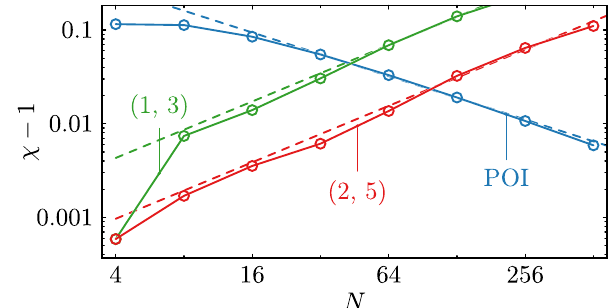
FIG. 5. Relative performance of the covariant, phase operator based interferometer (POI) (blue) and the variational (1,3) and (2,5) interferometers (green and red points, respectively) with respect to the OQI for a given system size N . The χ ratio is defined in Eq. (12), OQI corresponds to χ ¼ 1 . The dashed lines represent empirical scalings, green and red one scale as ∼ N , and blue is ∼ N − 0 . 77